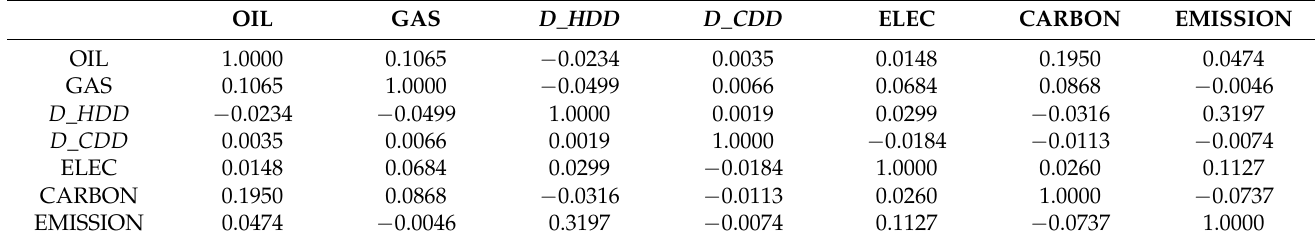
Table 4. Correlation matrix of all the indicators in the second layer system.